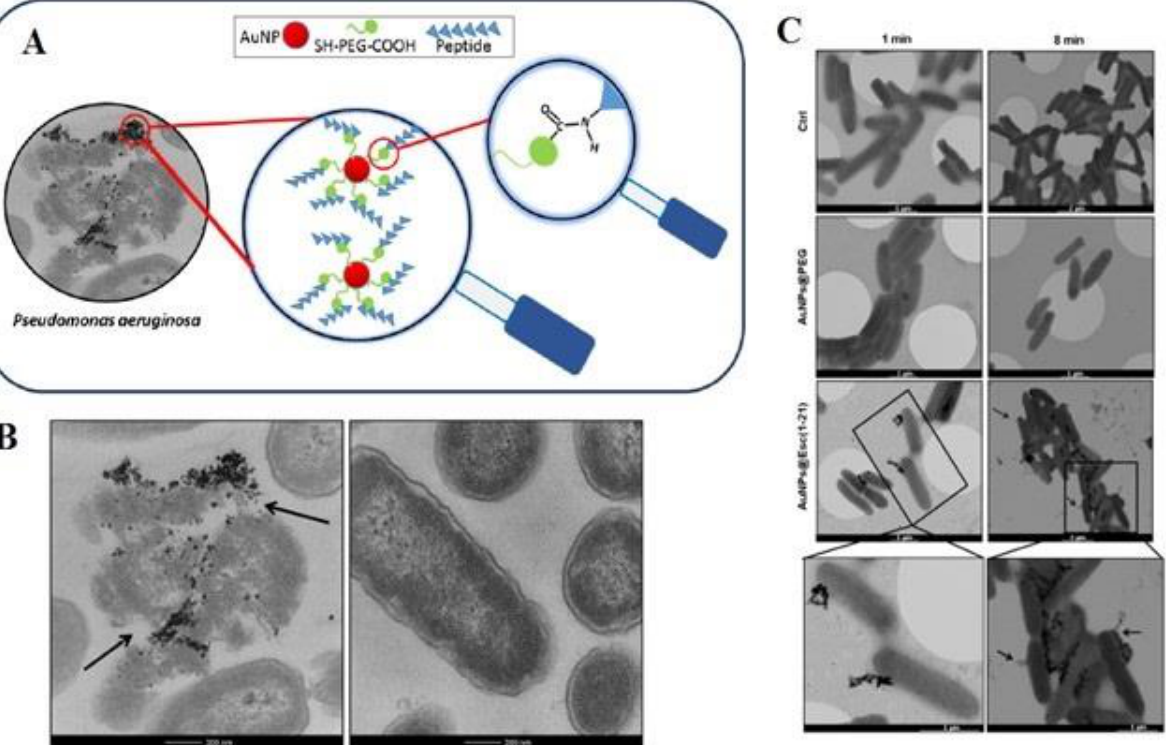
Figure 3. ( A ) Image of Esculentin-1a (1-21)-NH2 coated Au NPs and its interaction with bacteria. ( B ) Treatment of P. aeruginosa with ( left ) Au NPs@Esc(1-21) and ( right ) buffer as a control. ( C ) Schematic of P. aeruginosa cells treatment with Au NPs@Esc(1-21), Au NPs@PEG, and buffer [137]. Reprinted with permission from Elsevier.